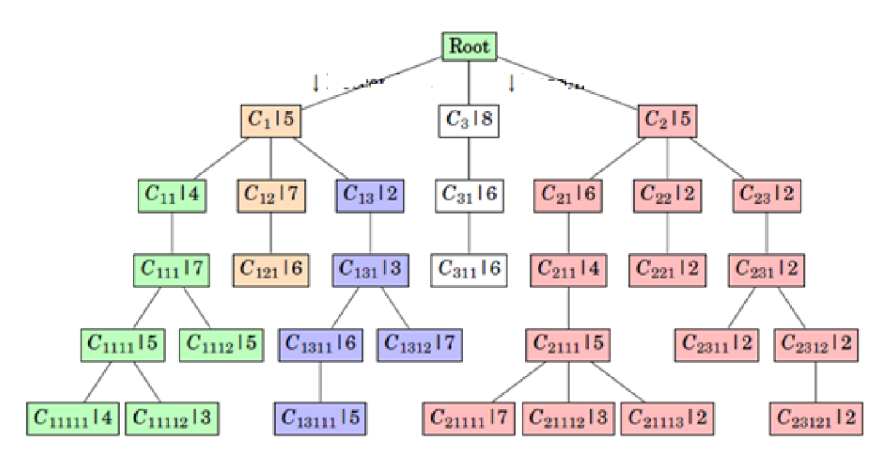
Fig. 2. Example of